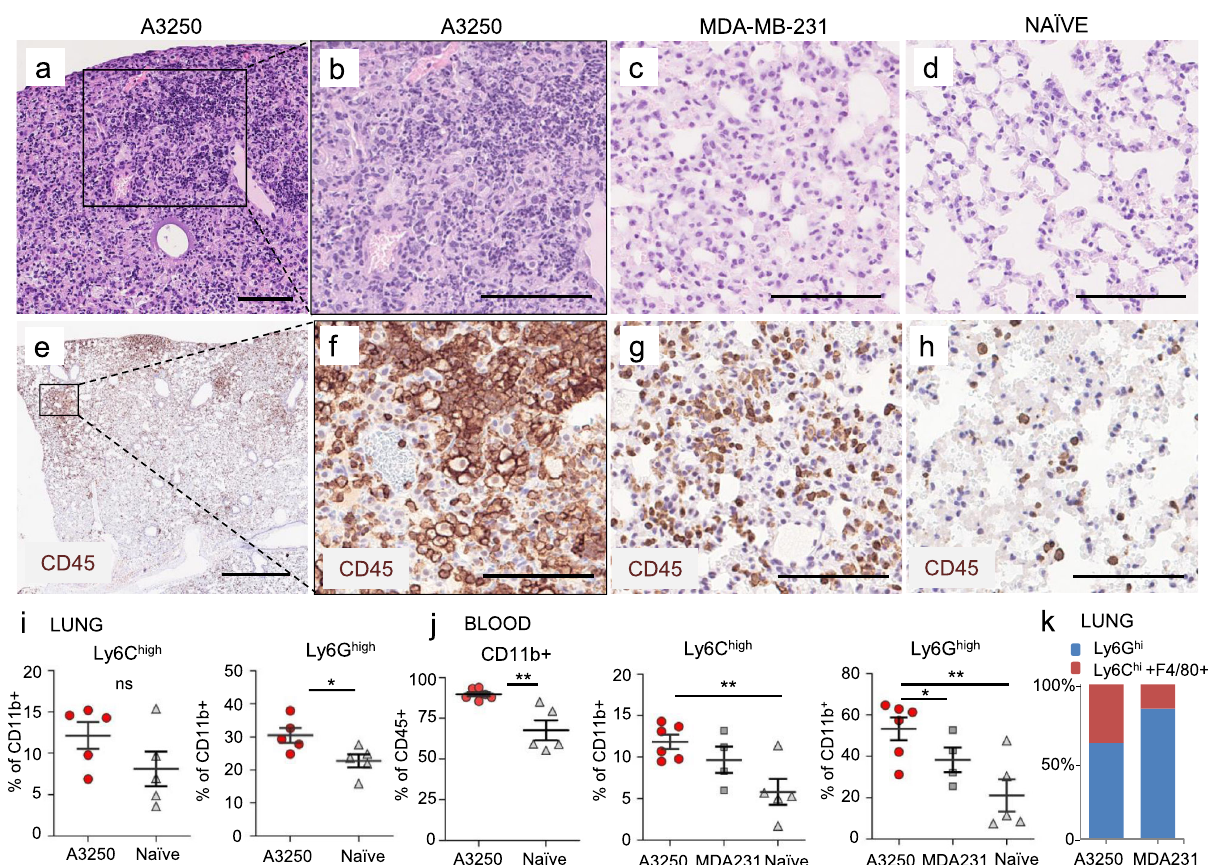
Fig. 6 Lung in fl ammation in mice bearing A3250 tumors. a – h Lungs of mice bearing A3250 or MDA-MB-231 tumors at 4 weeks post-injection, and tumor-naïve lungs from age-matched SCID mice as indicated. Sections were stained with H&E ( a – d ) or immuno-stained for CD45 ( e – h ). i Frequency of myeloid cell subsets in lungs from A3250 tumor-bearing and naïve mice determined by fl ow cytometry (%Ly6C: p = 0.09, %Ly6G: p = 0.0146). n = 5 lungs in each experimental group. j Frequency of myeloid cell subsets in blood from tumor-bearing and naïve mice as indicated, determined by fl ow cytometry (%CD11b + : p = 0.00373; %Ly6C + : p = 0.00629; %Ly6G + : p = 0.00728). n = 5 blood samples for naïve mice and 6 for mice with A3250 tumors A two-tailed t test was performed to determine signi fi cance ( i , j ). k Ratio of myeloid cell subsets in lungs as indicated. Black line on the plots indicates mean ± SEM. Scale bars: ( a ), ( e ), 1 mm; ( b – d ), ( f – h ), 100 μ m.** p < 0.01 * p < 0.05; ns, not signi fi cant. Source data are provided as a Source Data fi